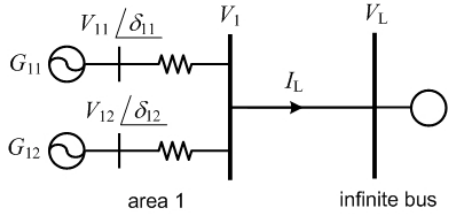
Figure 5. Equivalent system with infinite bus.